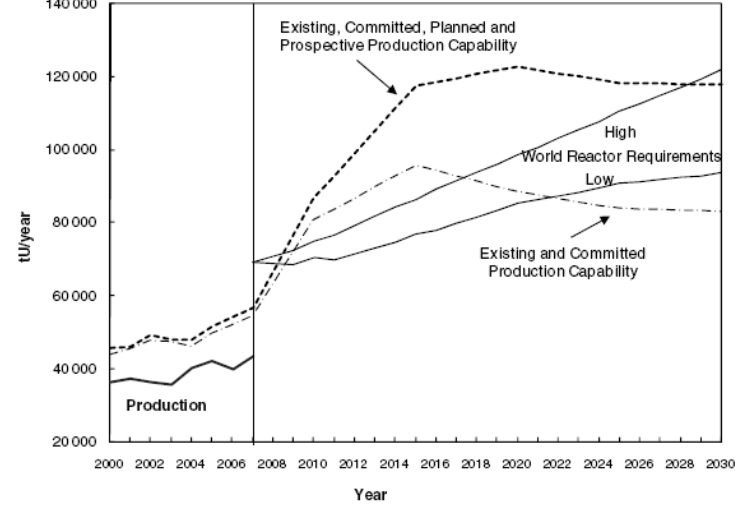
Figure 29. Annual uranium production capability versus requirements. © 2008 OECD, reproduced with permission from